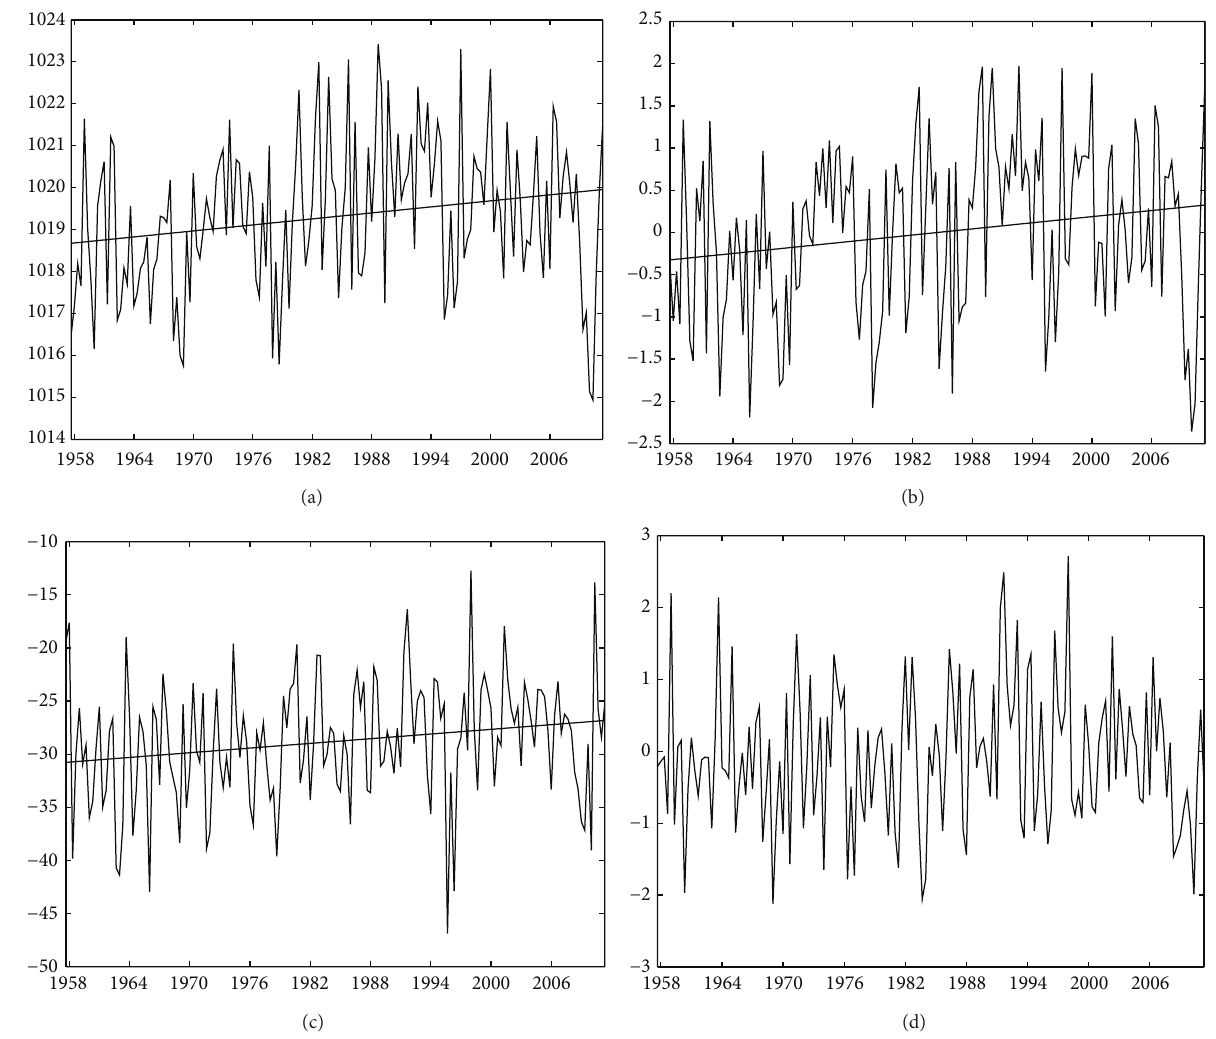
Figure 3: (a) Monthly mean Azores High sea level pressure and trend (mb), DJF 1958–2011; (b) monthly mean NAO index and trend, DJF 1958–2011; (c) monthly mean Azores High longitude (degrees east) and trend, DJF 1958–2011; (d) monthly mean EAWR index, DJF 1958–2011. Only trends which are significant at 𝑃 = 0.05 are